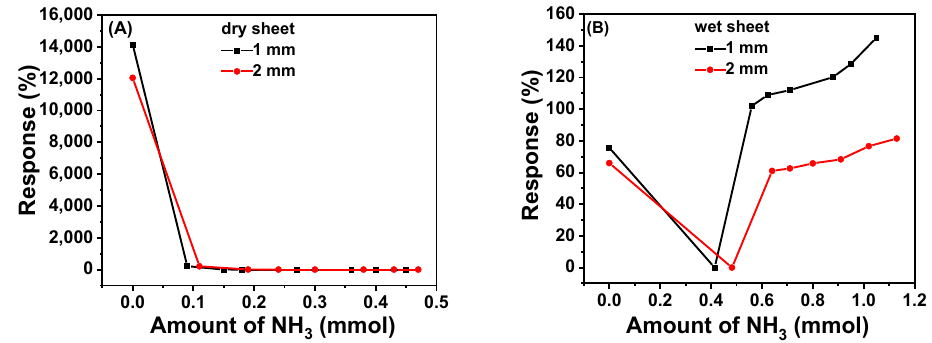
Figure 6. Response of 2-2 cryogel sheets to adsorbed NH 3 gas ( A : dry state; B : wet